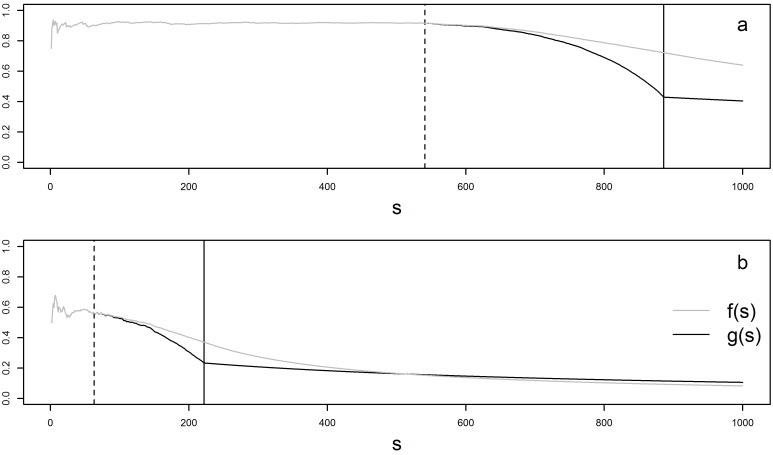
Values of f(s) and g(s) for simulation s = 1: 1000.The simulations displayed before the vertical plain line lead to null rejection (p—value < 0.05). They are sorted by increasing number of FP SUs. The dotted line represent the last simulation resulting in a detected cluster without FP SUs. The functions f(s) and g(s) represent respectively the computation of TCa and TCc over the m′ simulations. (a) simulated cluster with the maximum value of TCa—TCc and (b) simulated cluster with the minimum value of TCa—TCc.